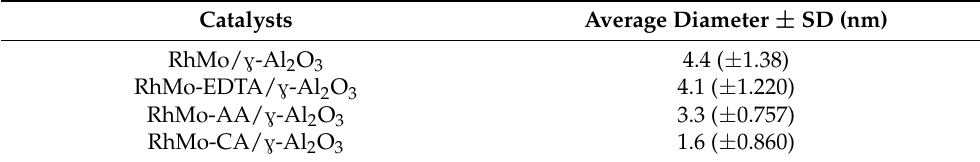
Table 4. Average length of MoS 2 crystallites in RhMo/Al 2 O 3 and RhMo-x/ G -Al 2 O 3 (x = EDTA, AA,